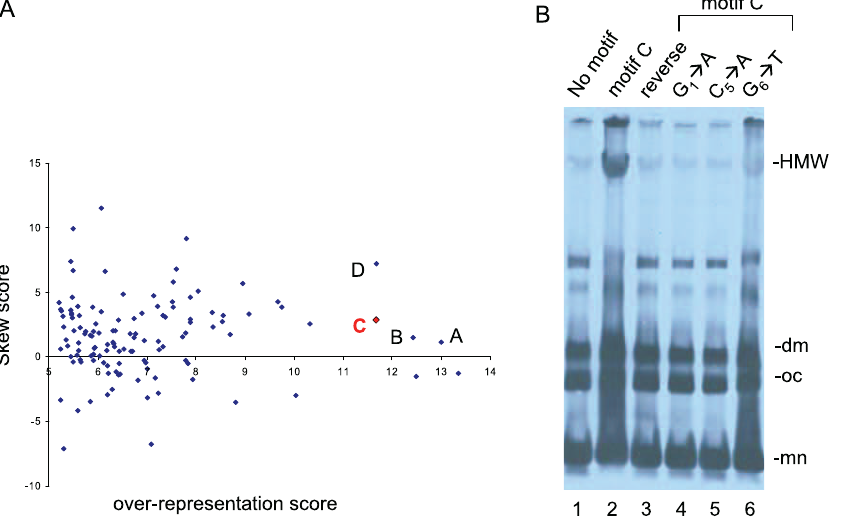
Figure 2. Motif C, 5 9 -GAAGCGG-3 9 , Is the S. aureus Chi Site (A) Overrepresentation and skew of heptamers on the S. aureus backbone. Plots are represented as in Figure 1. Only heptamers with an overrepresentation score higher than 5 (corresponding to a p -value , 10 (cid:2) 7 ) are shown. The four best candidates (motifs A to D) are indicated. (B) Experimental validation that motif C has Chi activity in S. aureus . Motif C was cloned in plasmid pRC and evaluated for HMW accumulation, an indicator of Chi activity [27]. Total genomic DNA was hybridized with a probe specific to the RC plasmid. Plasmid monomer (mn), dimer (dm), and open circle (oc) forms, and HMW are indicated by arrows. Motif C (lane 2, 5 9 -GAAGCGG-3 9 ) is HMW-positive, but it gives a negative signal when cloned in the reverse orientation (lane 3) or when it carries a mismatch (lanes